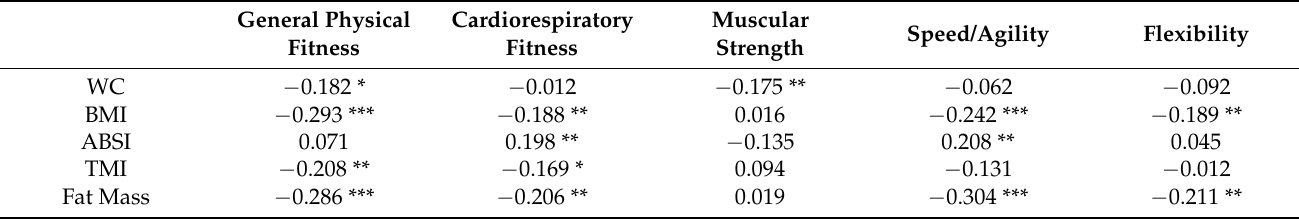
Table 4. Spearman rho correlations between the anthropometric indexes and International Fitness Enjoyment Scale in children with